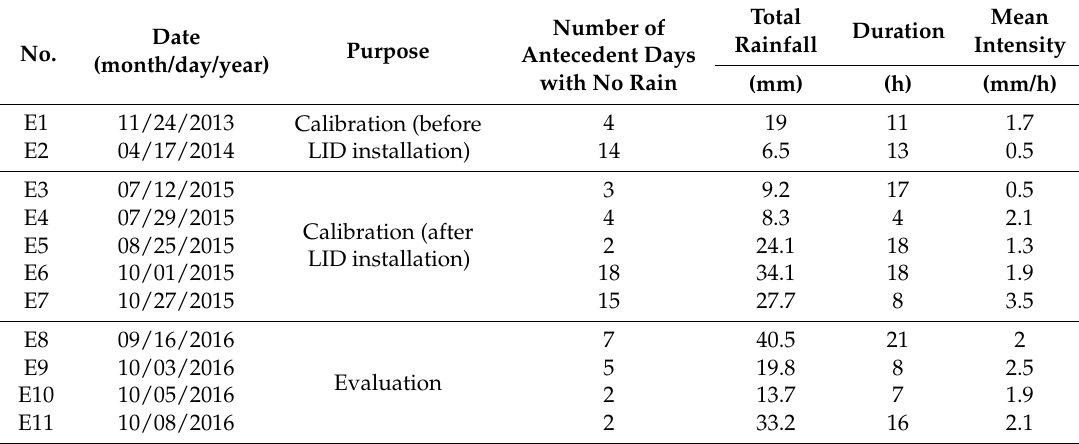
Table 3. Storm events used for model calibration and